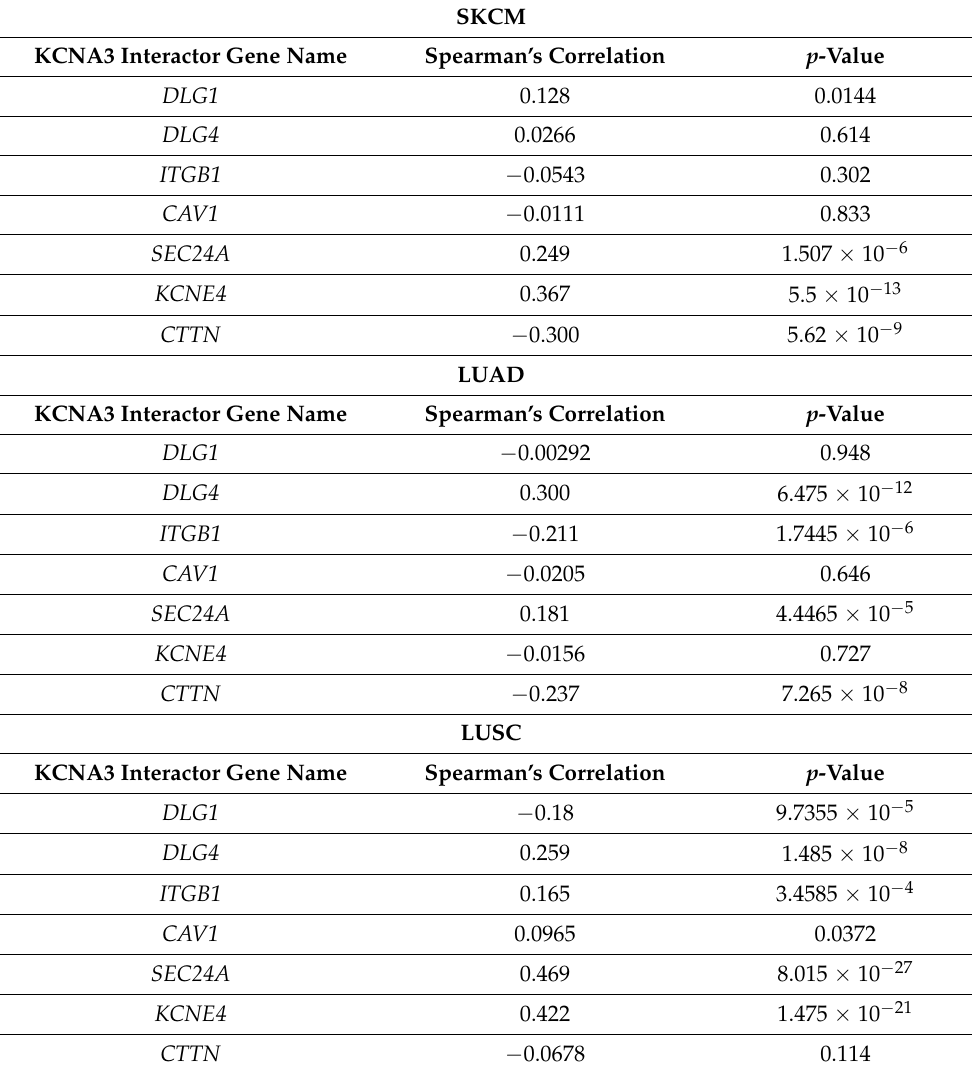
Table 1. Co-expression analysis was carried out by two pearson correlation analysis between the KCNA3 level of expression and the presented KCNA3 interactor using cBioPortal SKCM (363 sam- ples), LUSC (469 samples), and LUAD (507 samples) TCGA PanCancer Atlas datasets. Significant Spearman’s correlation values are reported in